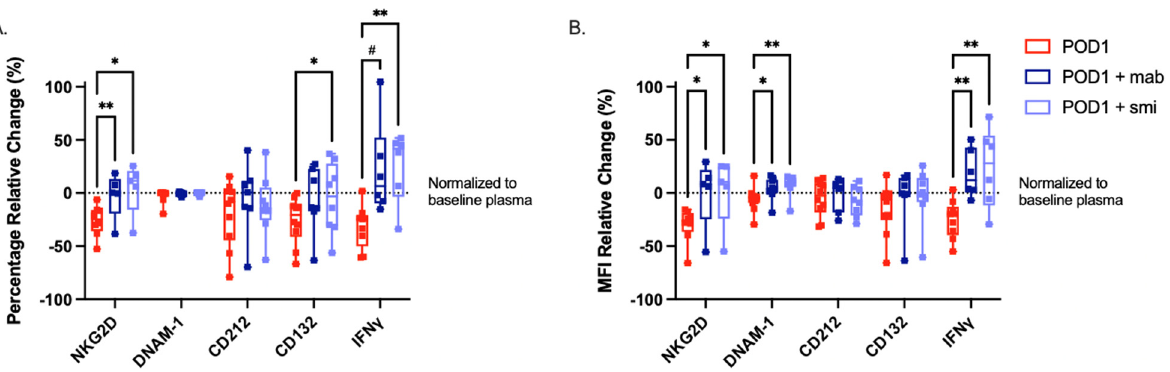
Figure 4. Anti-TGF- β therapies prevent POD1 plasma-induced NK cell dysfunction. Patient POD1 plasma (red) was pre-incubated with an anti-TGF- β monoclonal antibody (mAb) or isolated healthy NK cells were pre-incubated with the TGF- β R1 small molecule inhibitor (smi) SB525334. Box plot of NK cell activating receptor expression and IFN γ production (( A ) (%)/( B ) (MFI)) normalized to incubation in baseline plasma. Median ± IQR is shown. # p ≤ 0.1, * p ≤ 0.05, ** p ≤ 0.005.